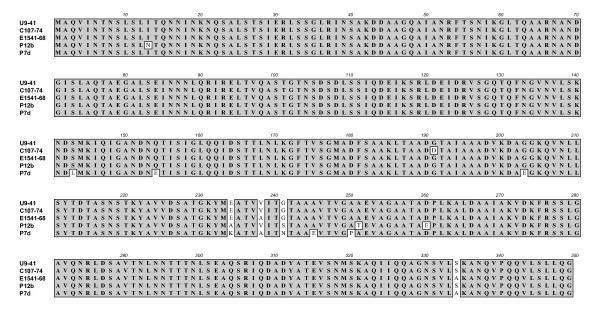
Alignment of the deduced FliC (flagellin) sequences from E. coli strains representing the flagellar antigen H4 and its genetic variants: U9-41 (accession BAA85081); C107-54 (accession CAE53943), E1541-68 (accession CAD60547); P12b (accession CAD56695); and P7d (accession CAE53942).